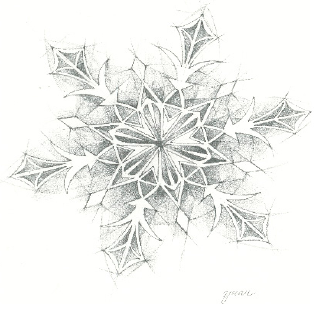
Figure 2. Elsa’s signature snowflake.